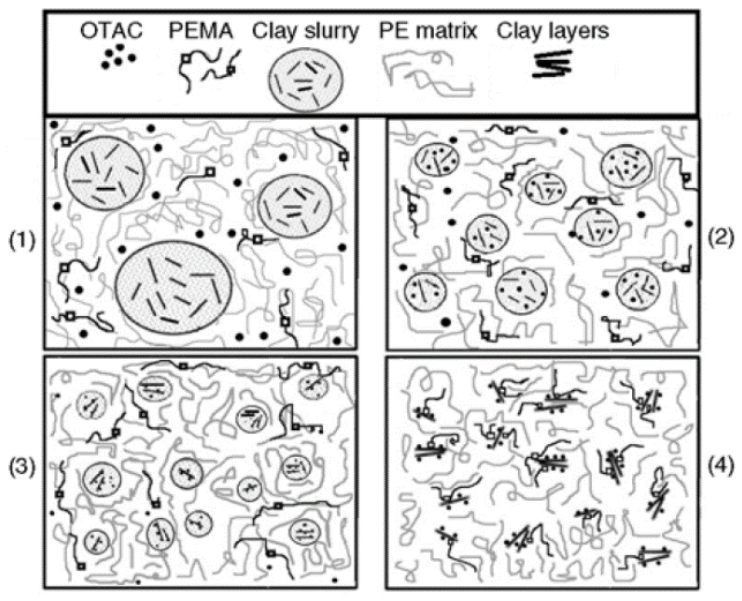
Figure 4. Schematic view of the intercalation mechanism in four steps in water-assisted (WA) melt compounding of polyethylene (PE) with clay slurry in presence of surfactant (OTAC) and compatibilizer (PEMA) ( 1 ) injection of clay slurry into the molten PE at high pressure; ( 2 ) OTAC is diffusing into the finer clay slurry drop and enter into cation exchange reaction; parallel to that water starts to evaporate; ( 3 ) water evaporation yields finer clay drops; cation exchange proceeds and compatibilizer works for uniform dispersion of the clay; ( 4 ) after complete evaporation of water the intercalates clay stacks and exfoliated layers are stabilized by OTAC and compatibilizer PEMA, especially when the latter contain coreactive groups (with permission of BME-PT)